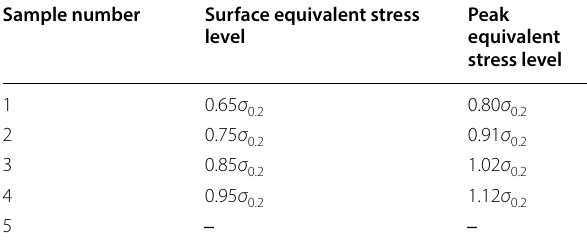
Table 7 Surface and peak equivalent stress level Sample number